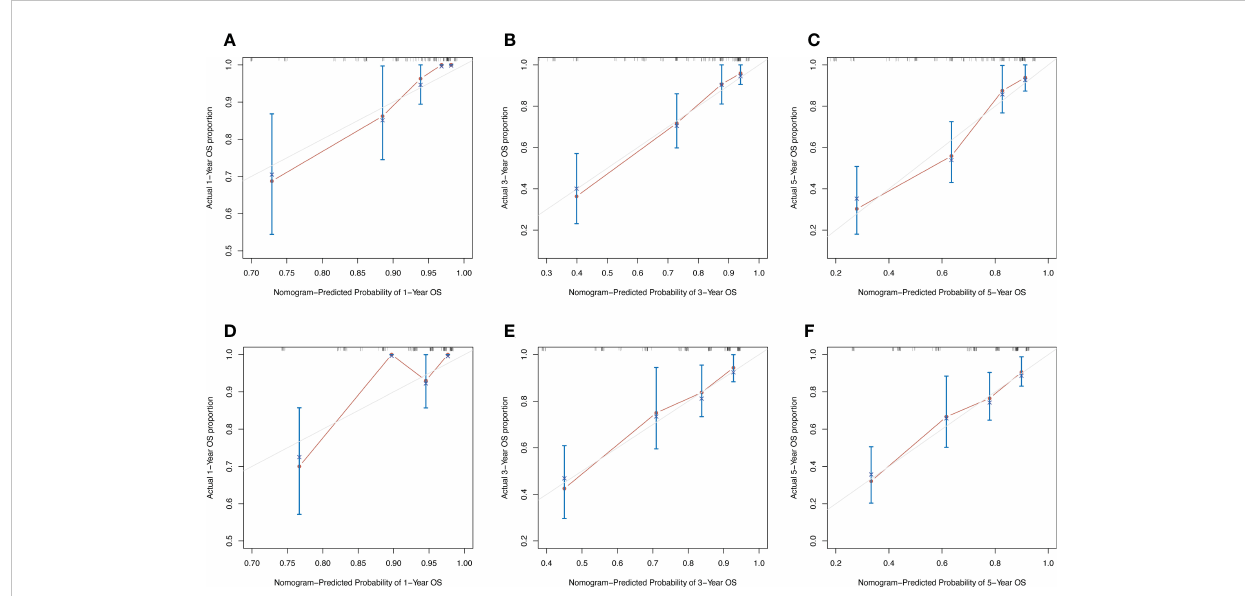
FIGURE 6 Calibration curves of 1-year, 3-year and 5-year OS predicted by two models. (A – C) Calibration curves of new nomogram prognostic model. (D – F) Calibration curves of TNM prognostic model.